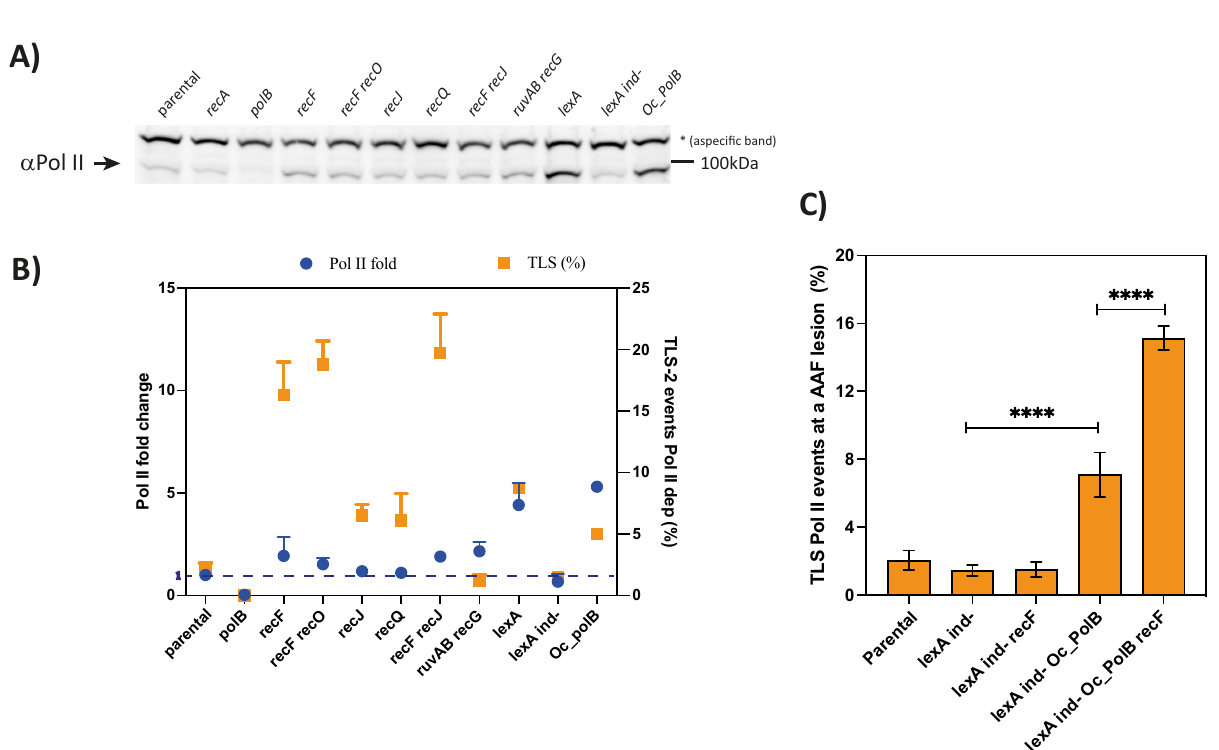
Fig 3. The presynaptic phase modulates TLS pathway independently from SOS induction. A) Western blot measuring the expression level of Pol II. As negative control polB deficient strain was used, while the lexA strain was used as positive control. The asterisk indicates an aspecific band recognized by the anti-Pol II antibodies. B) Graph correlating the Pol II fold change with the percentage of Pol II TLS events measured with our in vivo genetic system. The fold changes, compared to our parental strain, were quantified by Image Lab software (Biorad) and represent the average and the standard deviation of 2–3 independent experiments (see also S2A Fig). NB: For some dots the error bars are not visible because they are too small. C) The graph represents the percentage of Pol II TLS events in the presence of a G-AAF lesion. The data for lagging and leading have been pooled together and represent the average and standard deviation of at least three independent experiments. Statistical analyses have been performed with Prism using an unpaired t -test. ��� p < 0,0005. LexA ind- indicates a strain in which a specific mutation prevents LexA cleavage and therefore the SOS regulon can never be induced. Oc_polB indicates a strain in which polB is expressed under a constitutive